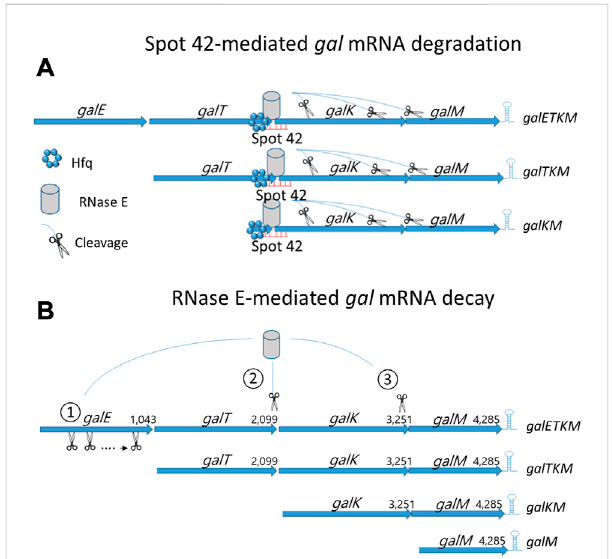
FIGURE 6 mRNA decay of the multicistronic galETKM. (A) Spot 42- mediated gal mRNAdegradation:Hfq-mediatedregionIIIbasepairing to galETKM , galTKM, and galKM recruit RNase E and subsequently induceRNaseEcleavage downstream. (B) RNaseE-mediated gal mRNA decay: 1) Generationof galTKM mRNA : The fi rst gene of the gal operon, galE , is removed by progressive and successive RNase E cleavages initiated at the 5 ′ end of galETKM mRNA. This progressive RNase E cleavage is followed by the 3 → 5 ′ exo-ribonucleolytic digestion of the released RNA fragment stops at the translation initiation site of the next galT gene, generating galTKM mRNA. The sites of RNase E cleavage that generate the 5 ′ ends of galTKM are presented in Figure 5A. The 5 ′ ends are experimentally shown (lane 1; Figure5D).2)Generationof galKM mRNA:SometimesRNaseEcleaves in the middle of galETKM mRNA, several nucleotides upstream from the translation initiation site of the galK gene, followed by the 3 → 5 ′ exo-ribonucleolytic digestion of the 5 ′ portion RNA fragment, which generates galKM mRNA, galKM . The sites of the RNase E cleavages that generate the 5 ′ ends of galKM are presented in Figure 5A. The 5 ′ ends are experimentally shown (lane 3; Figure 5D). 3) Generation of galM mRNA: RNase E cleavages on the upstream sites from the translation initiation of the last gene of the operon, galM , followed by the 3 → 5 ′ exo-ribonucleolytic digestion of the released RNA fragment generates galM mRNA, galM . The sites of the RNase E cleavages that generate the 5 ′ ends of galM are presented in Figure 5A. The 5 ′ ends are experimentally shown (lane 5; Figure 5D). RNase E also cleaves a few nucleotides upstream from the transcription terminator hairpin at the 3 ′ end of galM mRNA. Exoribonucleases rapidly remove the 5 ′ portion of the galM mRNA upstream of the hairpin structure, completing the decay process of the multicistronic full-length